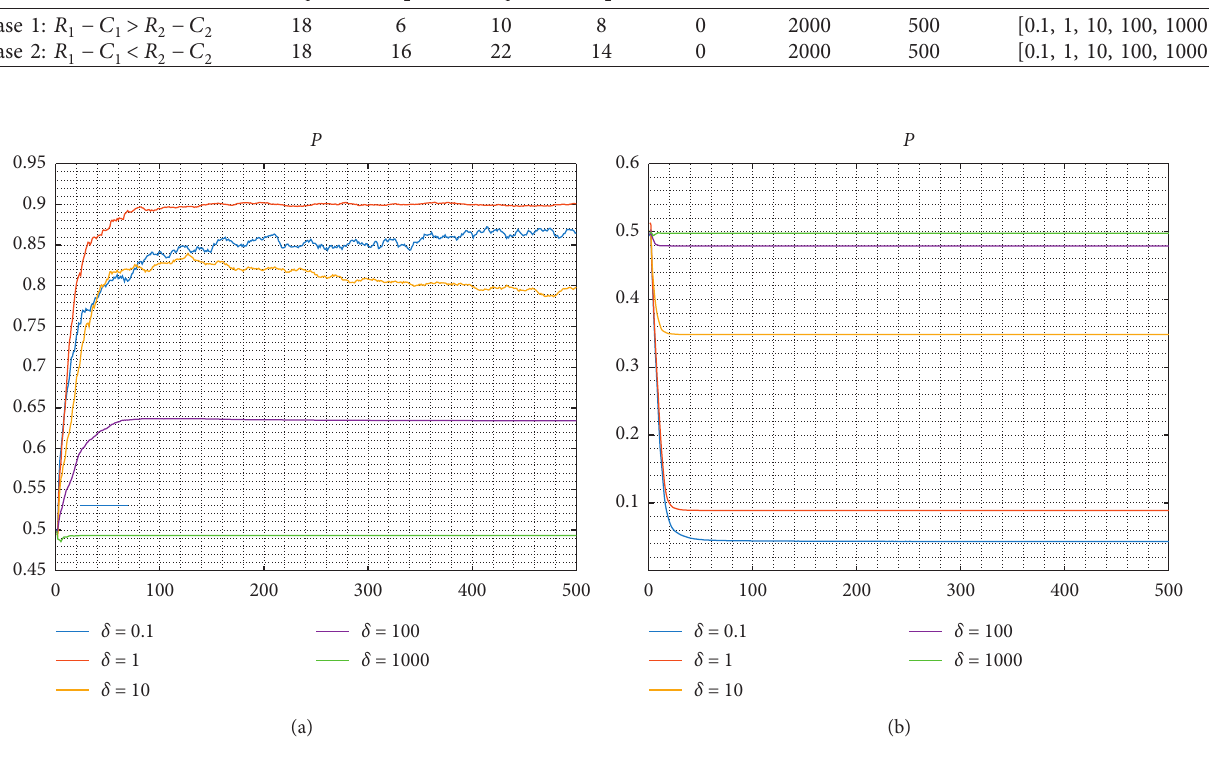
Figure 8: The simulated result considering the change of information noise. (a) P (Case 1). (b) P (Case 2). Table 9: Summary of simulated result considering the change of network size.